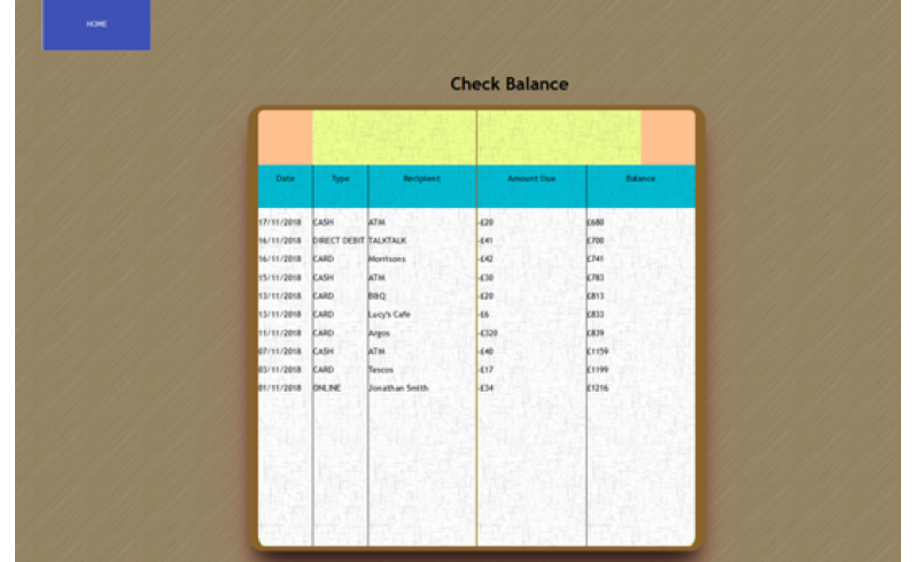
Figure 7. A screenshot of the transaction view page of our skeuomorphic